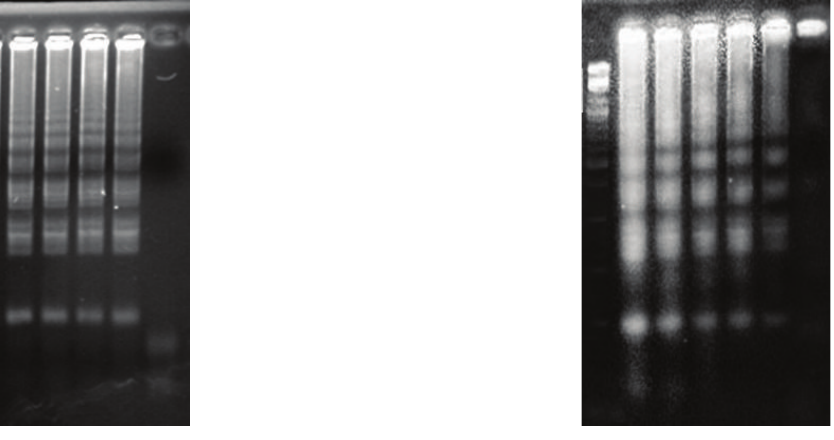
Figure 11: Turbidity in the traditional LAMP reaction for DNA samples at various concentrations: (1) 20 ng/mL, (2) 2 ng/mL, (3) 0.2 ng/mL, (4) 20 pg/mL, (5) 2pg/mL, and (6) negative control.